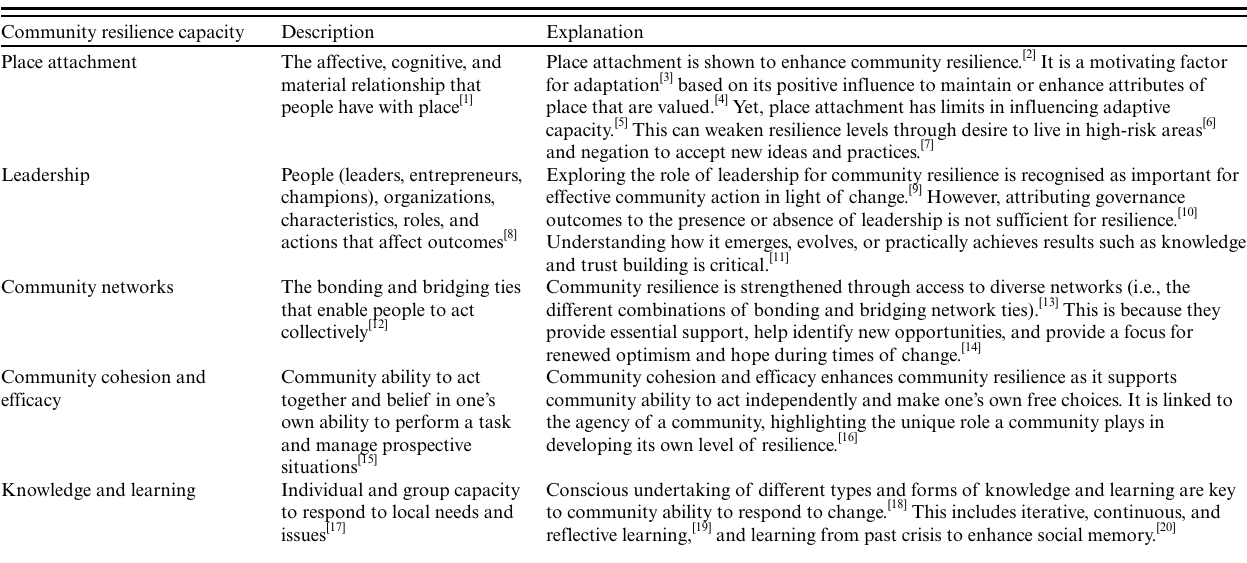
Table 1. Capacities assessed for community